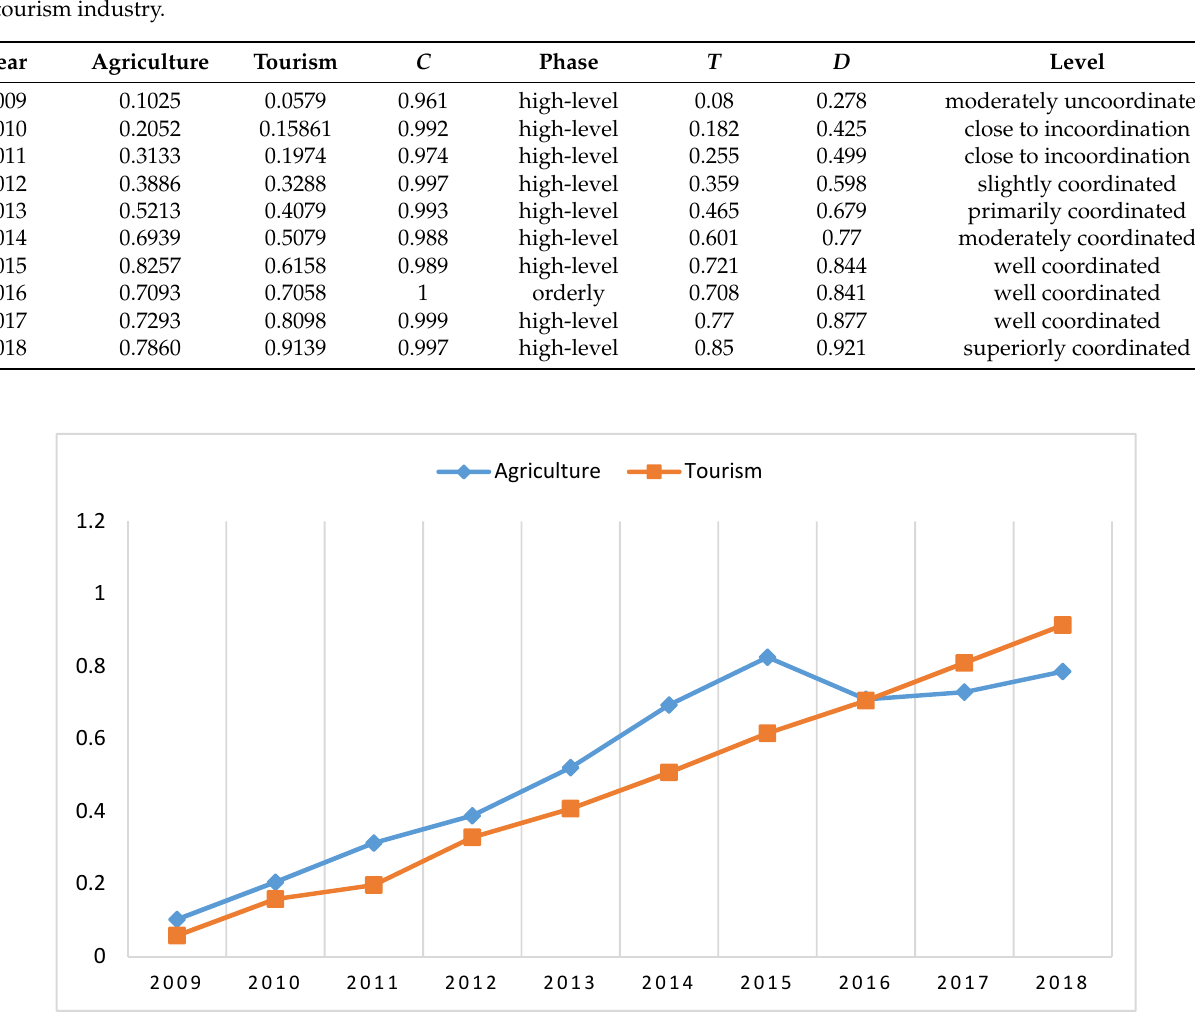
Figure 1. Development trend of the agriculture industry and the tourism industry.